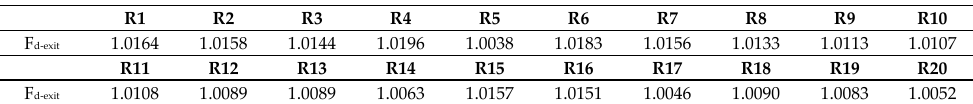
Figure 9. Exit delamination factor values of CFRP for all runs. Table 4. Pooled ANOVA of model for exit delamination of CFRP